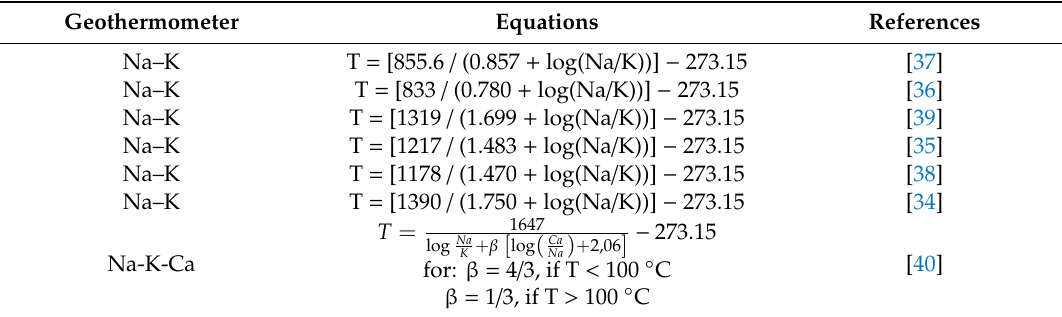
Table 1. Temperature equations ( ◦ C) for